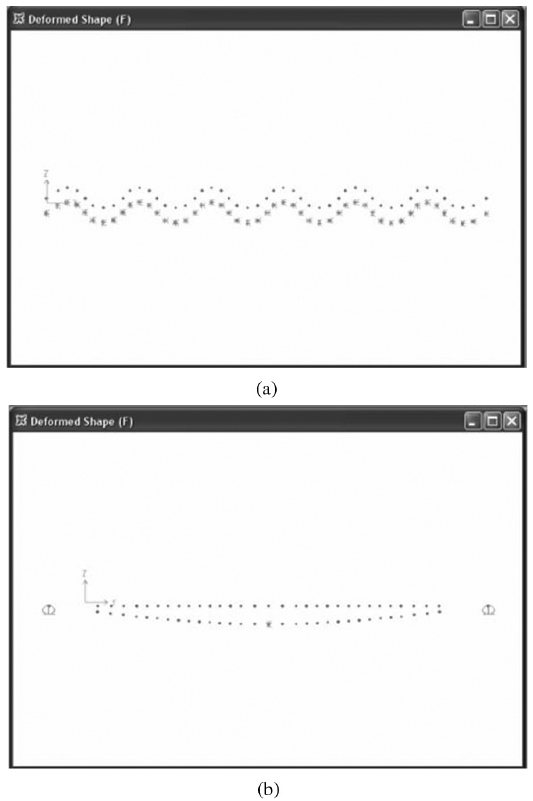
Figure 17. Deformed configuration of the sheets: (a) Transverse deformation in the center of span, (b) Longitudinal deformation between